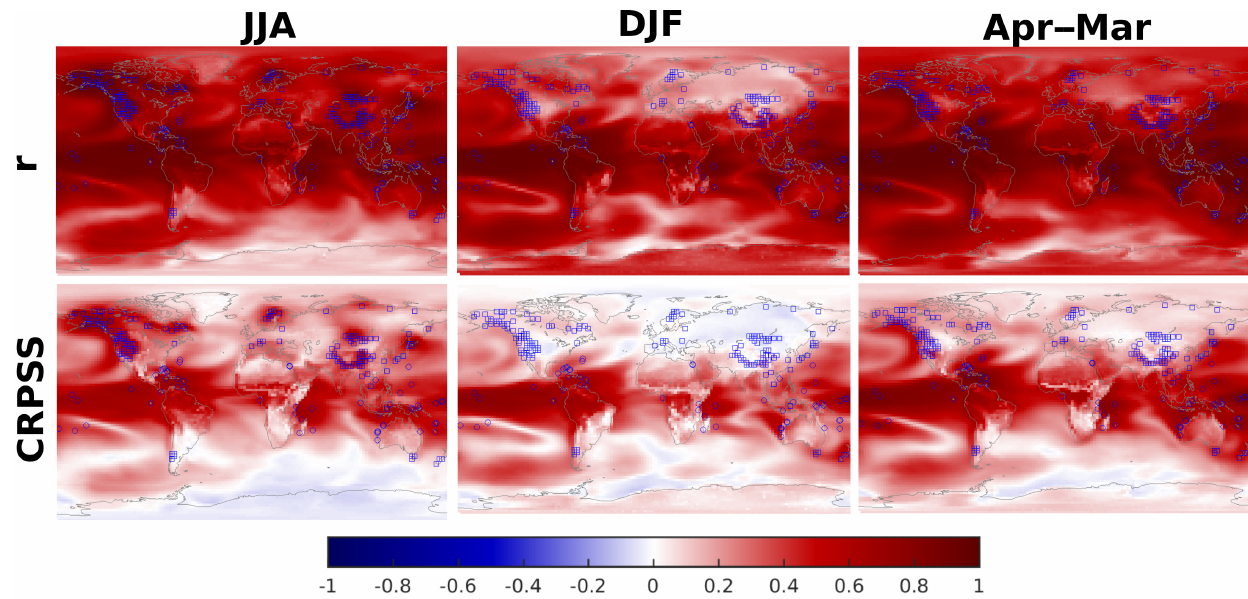
Figure 2. Reconstruction skill for 2m air temperature. Rows show the skill metrics of correlation ( r ) and the mean continuous ranked probability skill score (CRPSS). These skill metrics are computed for the entire 1000-year reconstruction against the true grid point time series, CESM LME simulation 10. Columns show the reconstruction skill for June–July–August (JJA) and December–January–February (DJF) seasonal means and the annual mean from April to the next calendar year’s March. Pseudo-tree sites are indicated by blue squares, and pseudo-corals are indicated by blue circles.